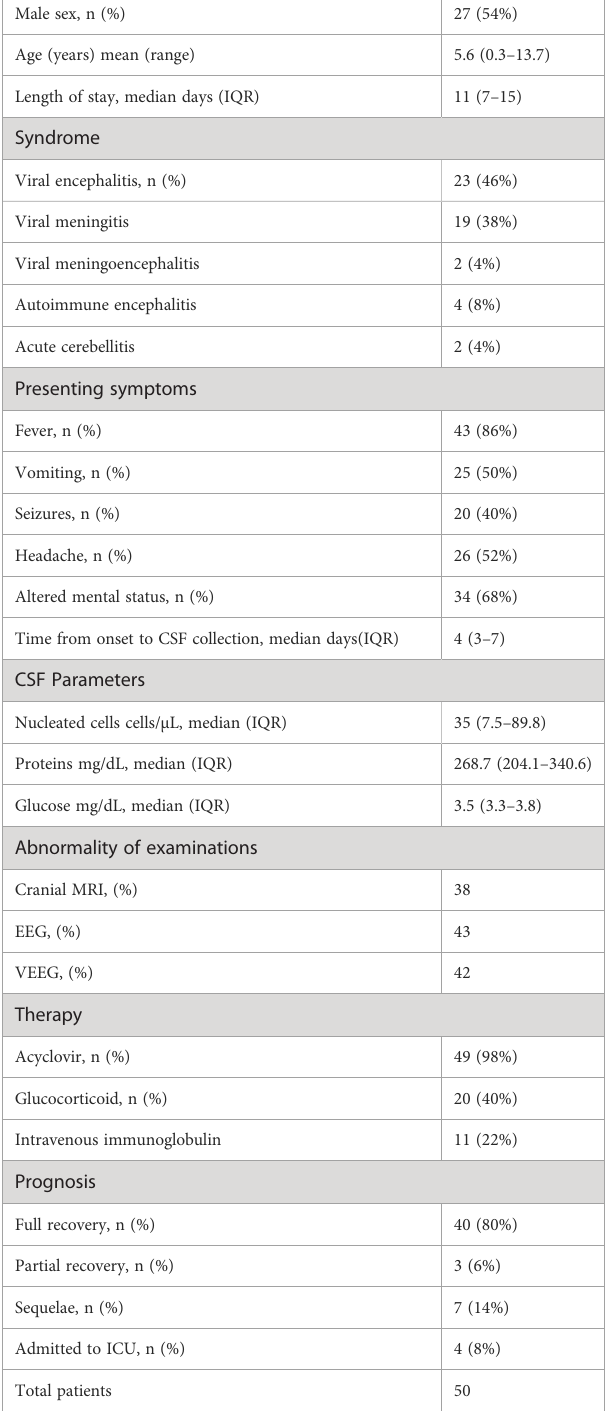
TABLE 1 Demographics and clinical statistics of research subjects (n =